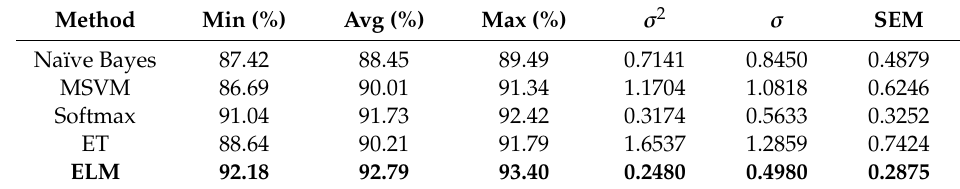
Table 12. Detailed statistical analysis of the proposed method using the BraTS 2018 dataset.